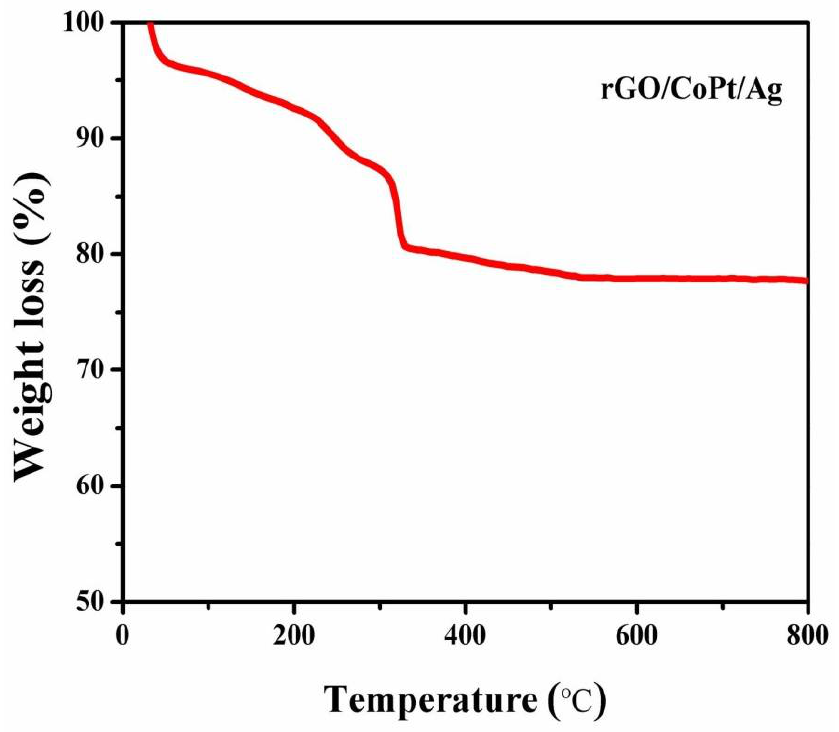
Figure 9. TGA thermogram of the rGO/CoPt/Ag catalyst. Table 1. Comparison of catalytic activity for the 4-nitrophenol reduction by different catalysts.